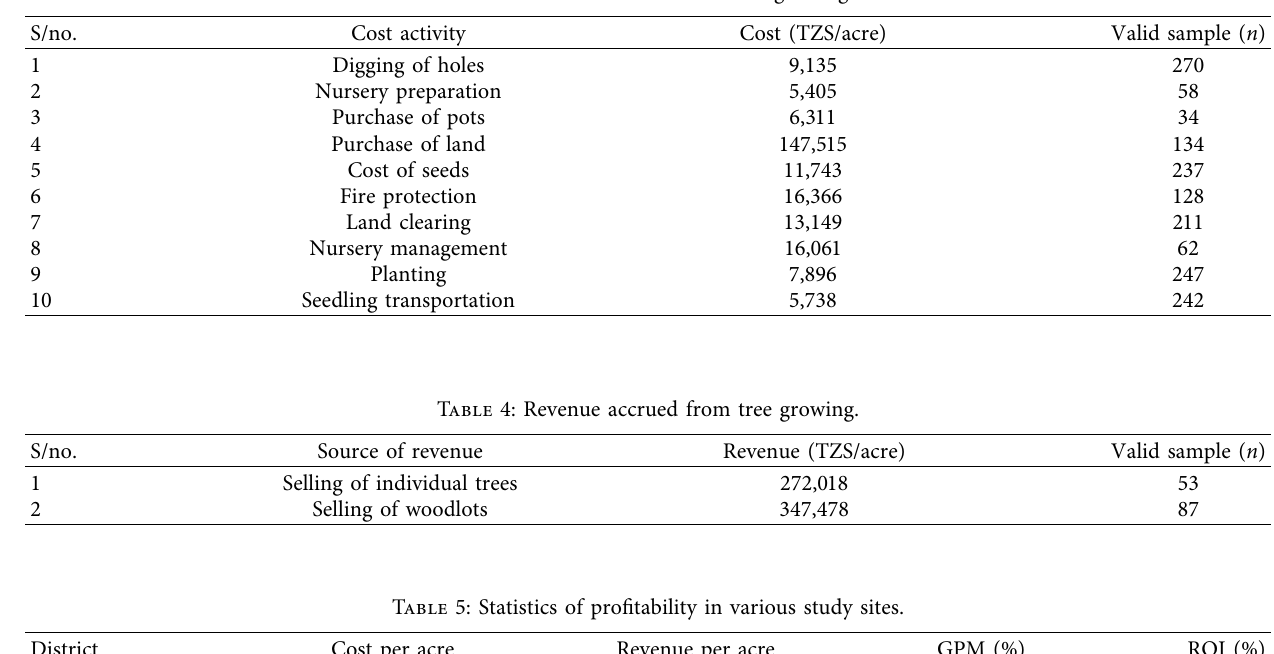
Table 3: Costs associated with tree growing.